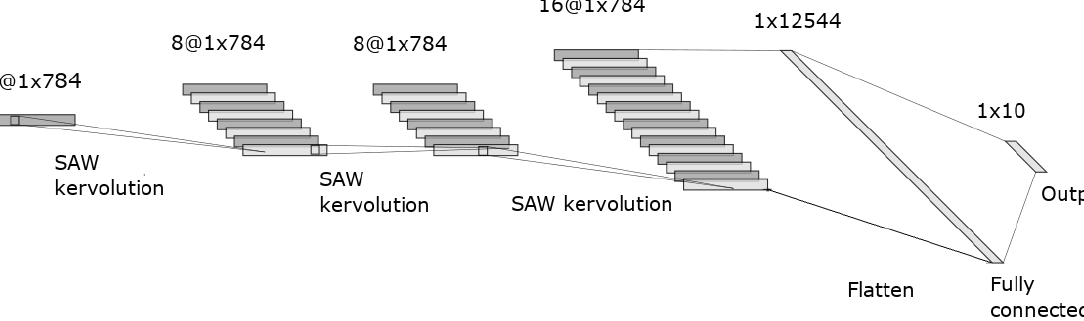
Figure 4. The architecture of our neural network model with SAW kervolution. The convolutions and ReLUs were substituted with kervolutions in this variant. Please note that the number of layers, channels, and parameters were the same in both network